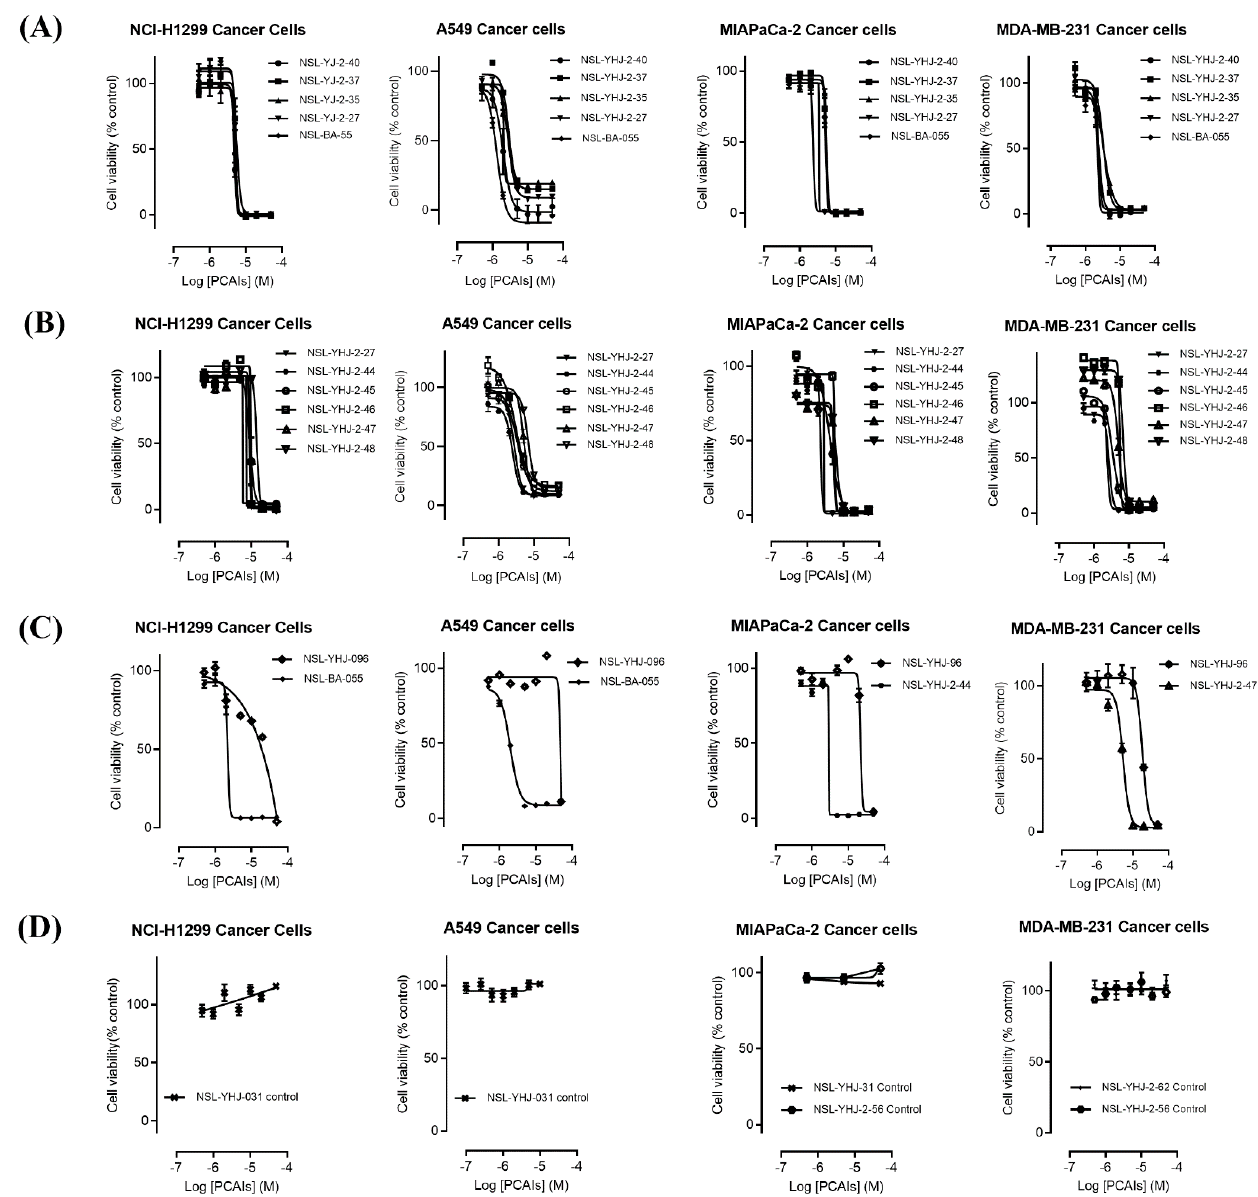
Figure 1. PCAIs analogs inhibit cancer cell viability. The effects of the PCAIs on the viability of human lung (A549 and NCI-H1299), pancreatic (MIA PaCa-2), and triple-negative breast (MDA-MB-231) cancer cells were determined following 48 h exposure to the respective PCAIs using the resazurin reduction assay. Each point represents the mean ± SEM, n = 3 relative to the control untreated cells. Concentration-response curves of ( A ) PCAIs with varying linker chain lengths, ( B ) PCAIs with varying cycloalkyl ring sizes, and ( C ) PCAIs with a free α -amino on the cysteine (NSL-YHJ-096) compared to some of the potent PCAIs analog; ( D ) analogs lacking the polyisoprenyl moiety showed no effects against cell viability.